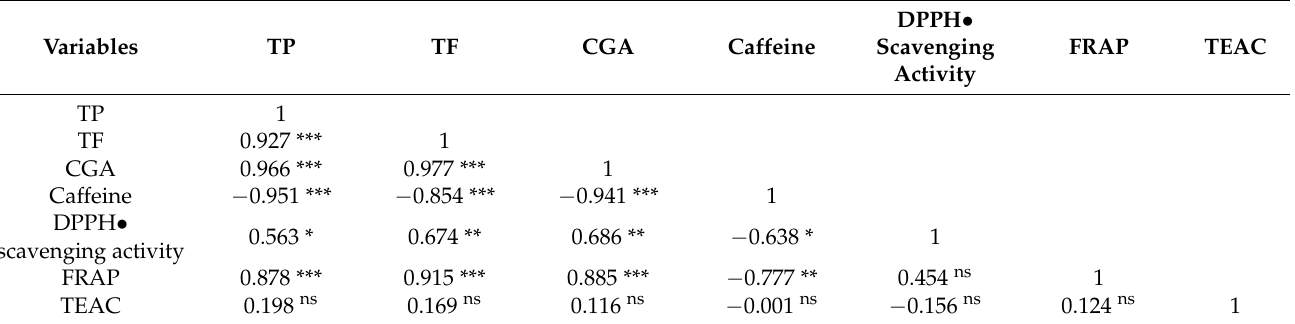
Table 7. Pearson’s correlation coefficients (r) for the total phenolics, total flavonoids, chlorogenic acids, caffeine contents, and antioxidant activities in the drip